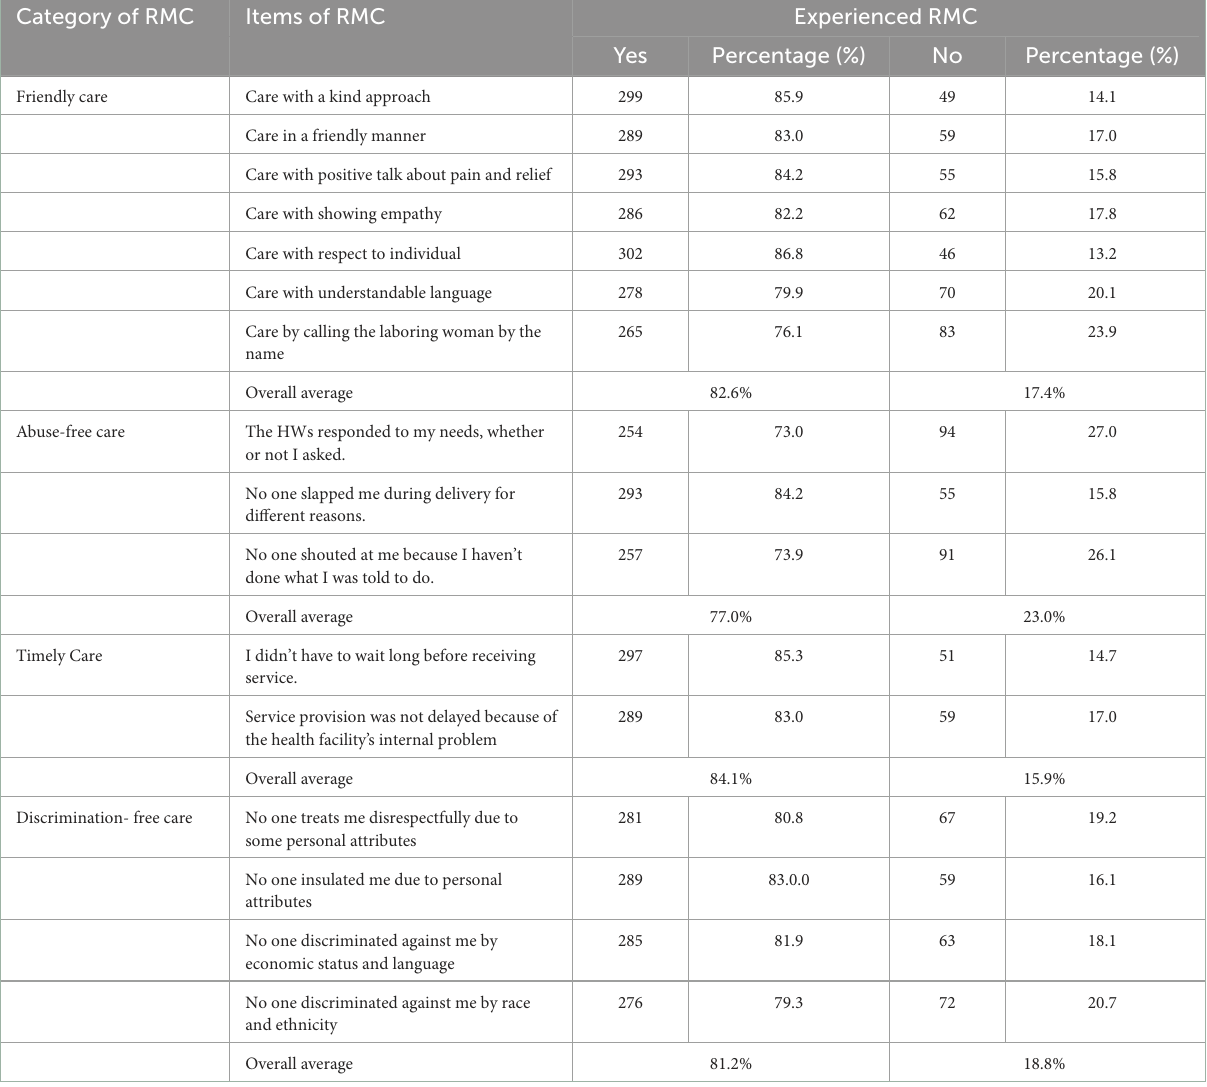
TABLE 3 Provision of RMC during childbirth at three public hospitals in Southwest Ethiopia, 2021 ( n = 348). Category of RMC Items of RMC Experienced RMC Yes Percentage (%) No Percentage (%) Friendly